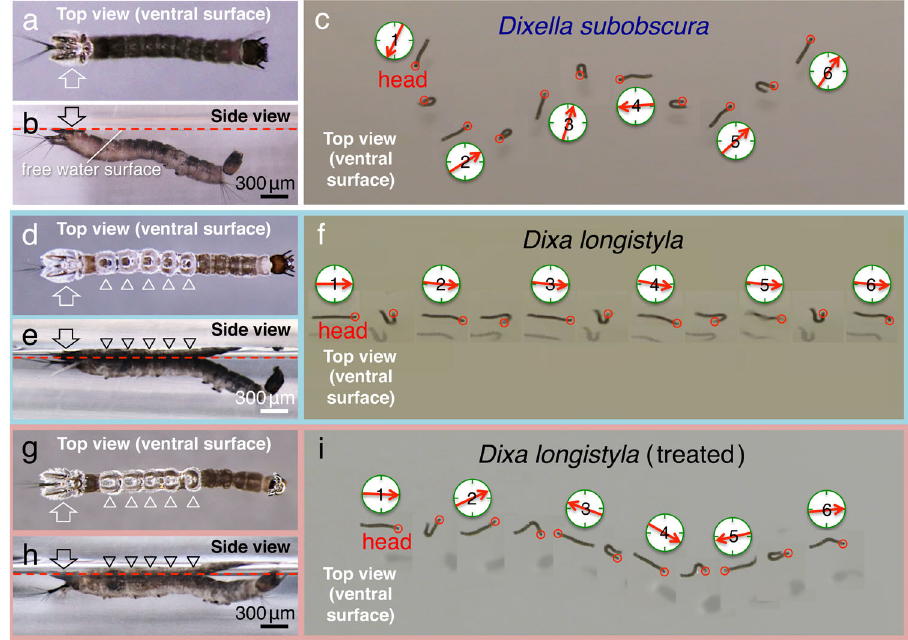
Fig 6 Observations of the larvae of Dixella subobscura and the larvae of Dixa longistyla in swimming behaviour. Comparison of the control larva of Dixella subobscura in a – c , the control larva of Dixa longistyla in d – f and the Dixa larva in which the crowns were treated with sun fl ower seed oil in g – i . a , d , g Top views. b , e , h Side views. c , f , i Images of the direction during the swimming movement of the larvae. The directions of the red arrows indicate the forward orientation of the